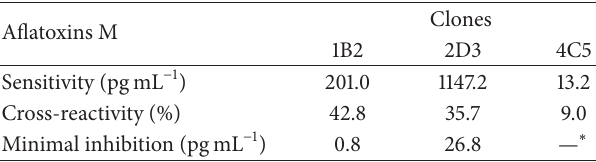
Table 3: Results of sensitivity (expressed as pg mL − 1 ) and